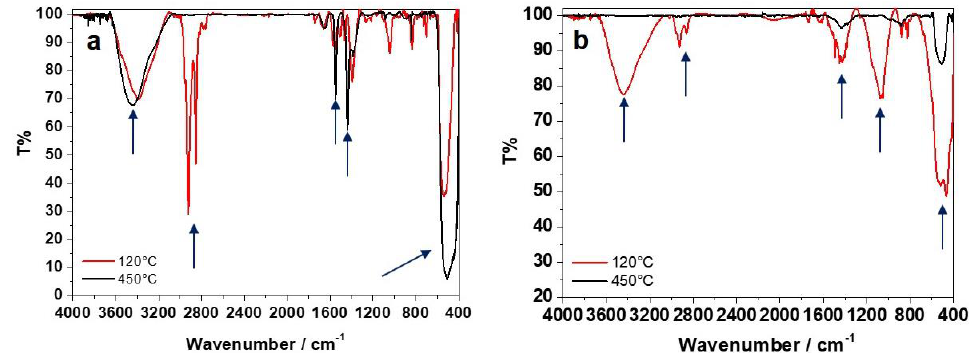
Figure 3. The FTIR spectra of dried (120 °C) and calcined (450 °C) samples: ( a ) ZnO-BAC; ( b ) ZnO-PDDA. The main IR modes are highlighted by arrows.